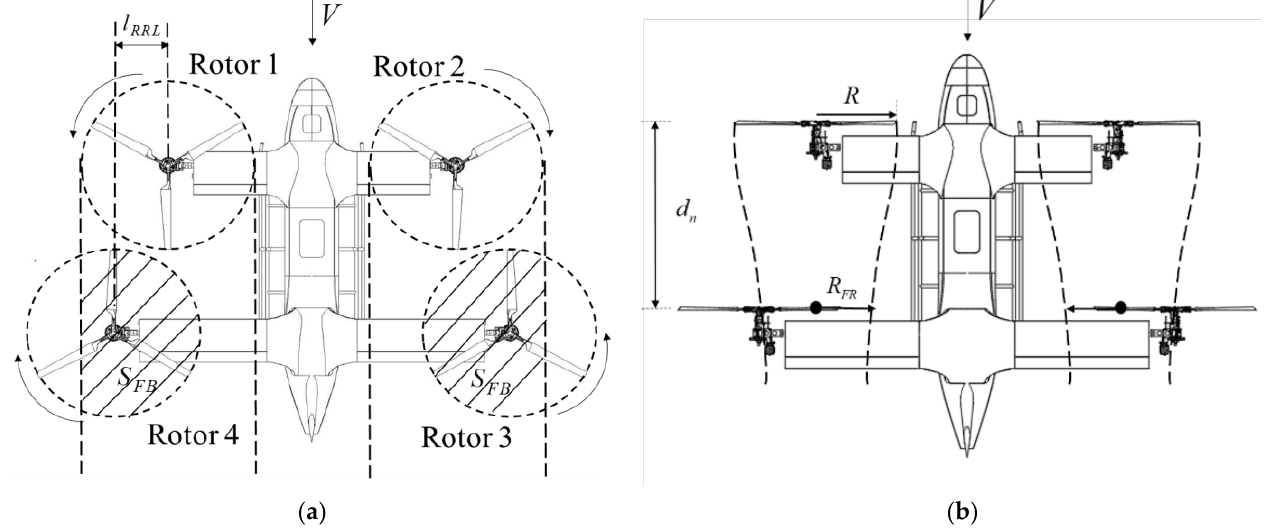
Figure 4. Interactional diagram of front rotor wake to the rear rotor. ( a ) Top view of longitudinal interaction (helicopter mode). ( b ) Top view of longitudinal interaction (airplane mode). where V is inflow velocity.